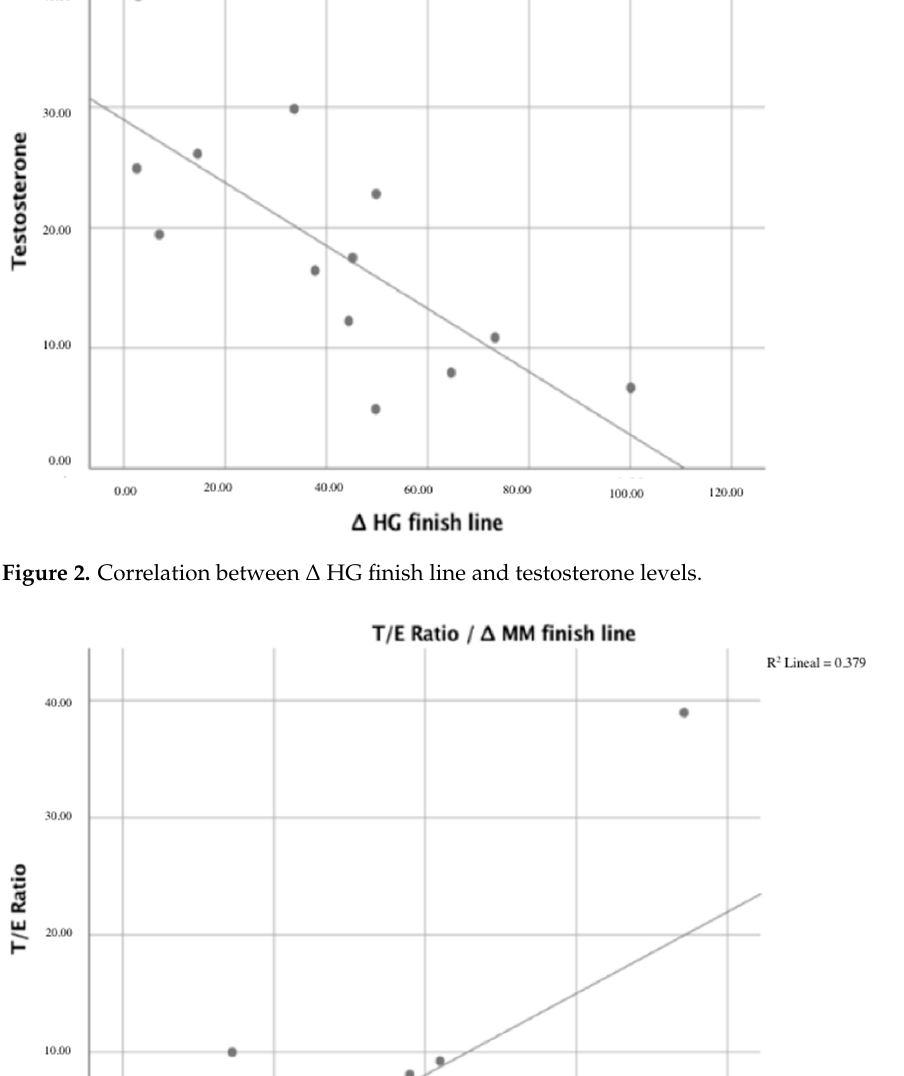
0.581, 0.595, 0.620, and 0.625, respectively.